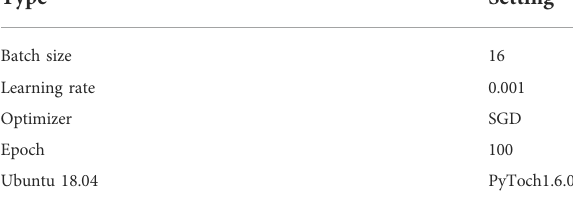
TABLE 1 Training parameter